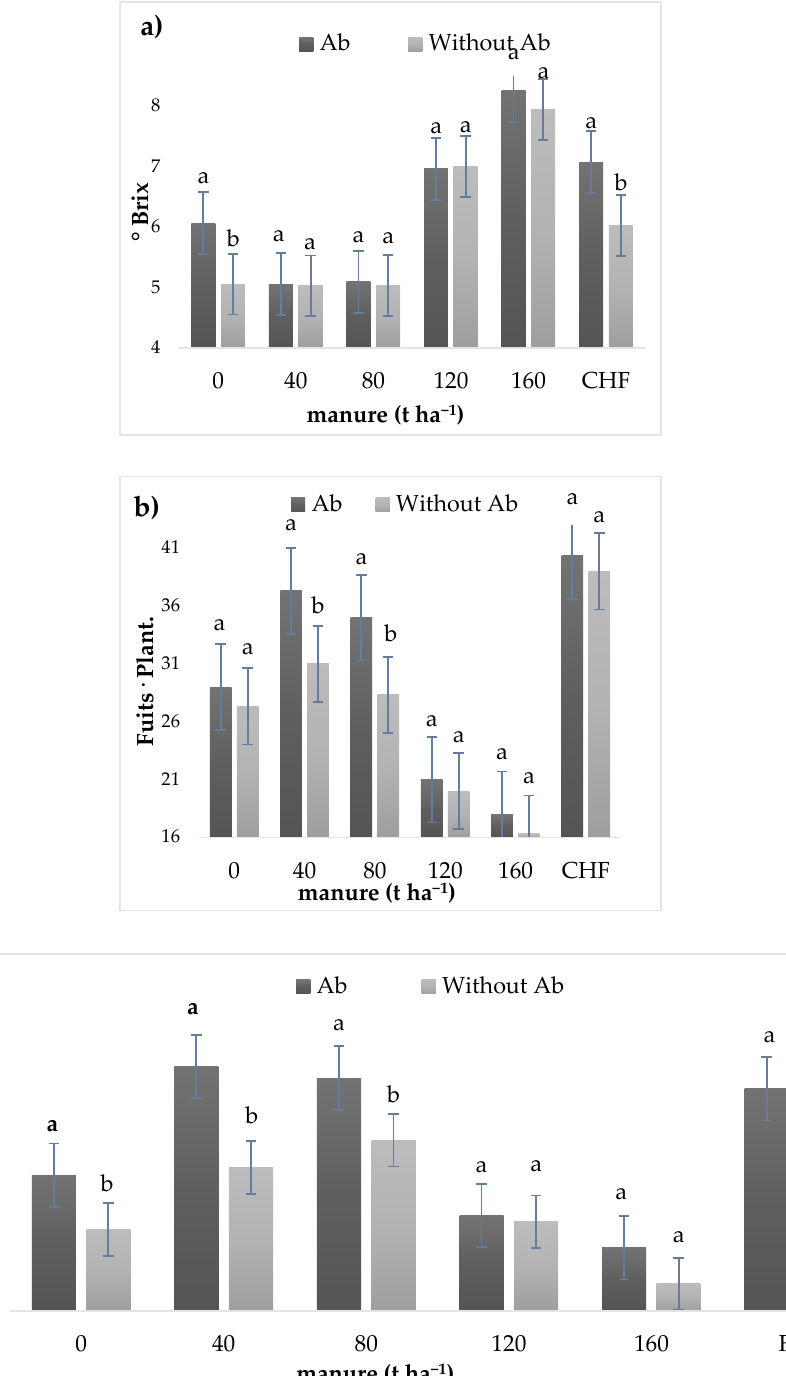
Figure 3. Interaction of Ab–Fertilization in soluble solids ( a ), fruits / plant ( b ) and yield per m 2 ( c ). Interaction of Ab–fertilization in terms of plant height at 5 months; Ab: Azospirillum brasilense ; 0, 40, 80, 120, 160 = manure t . ha −1 ; CHF: chemical fertilization. Different literals in the bars indicate significant difference with p < 0.05.